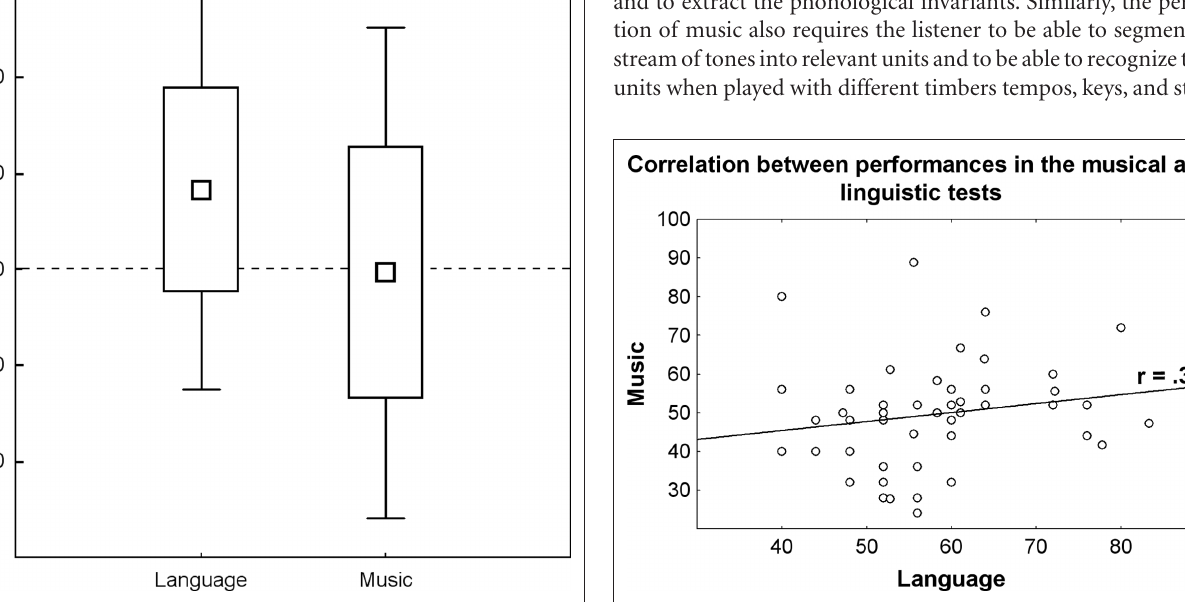
Figure 2 | Percentage of correct responses: box plot of performances in the linguistic (left) and musical tests (right). Data from Experiments 2 and 3 (Francois and Schön, 2010, 2011), are pooled together leading to N = 50 subjects (dashed line = 50%, chance level).